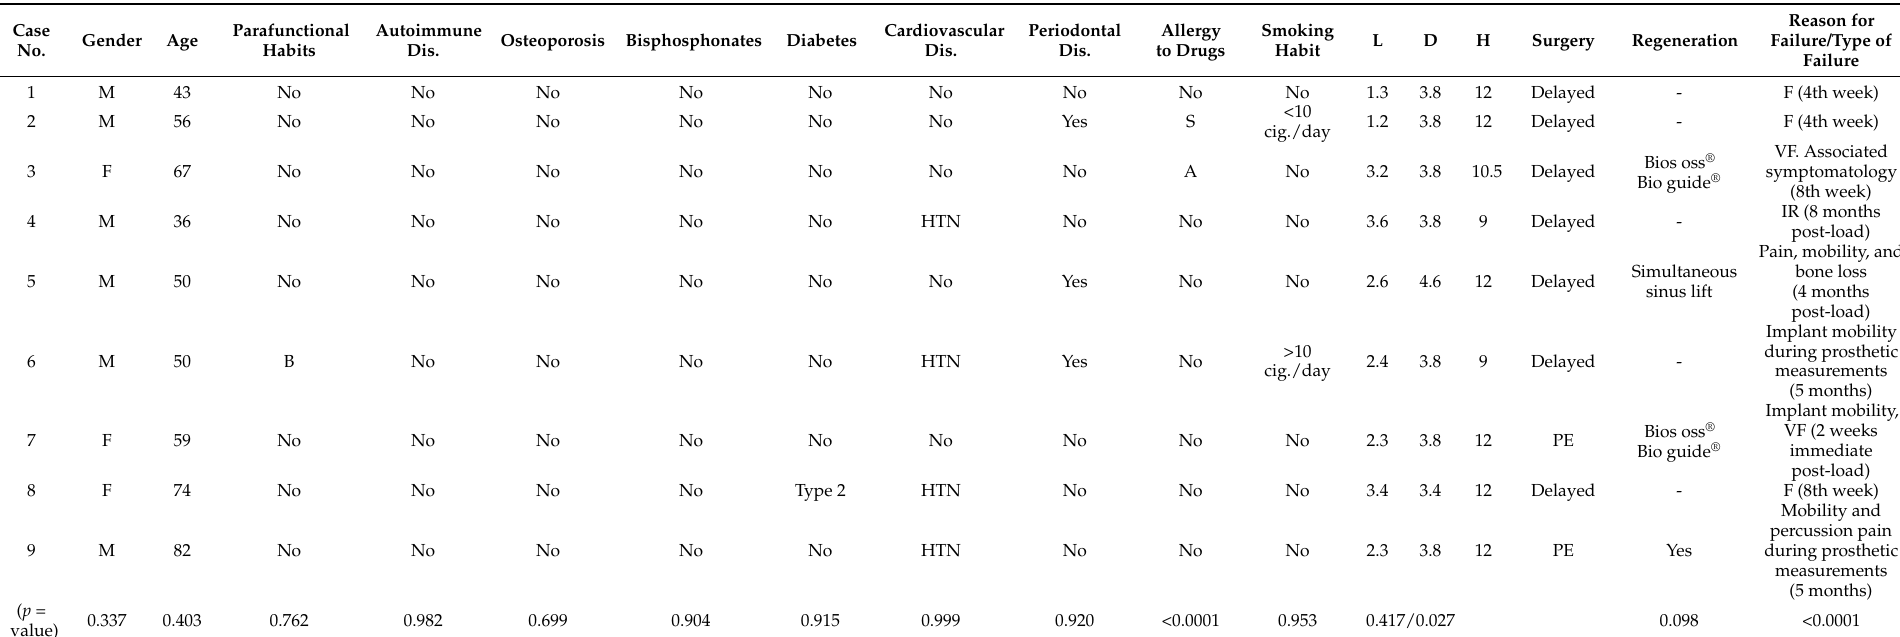
Table 7. Clinical characteristics of the failed implants. Dis: Disease; HTN: Hypertension; A: Penicillin, Tetracyclines, Streptomycin, Erythromycin, Lincomycin, Gentamicin, Sulfamethoxazole, Epinephrine, Chlorhexidine, Cobalt chloride and nickel chloride; S: Sulfamides; B: Bruxism; L: Location; D: Diameter; H: Height; PE: Post-extraction; F: Fibrointegration; VF: Vestibular fenestration; IR: Implant